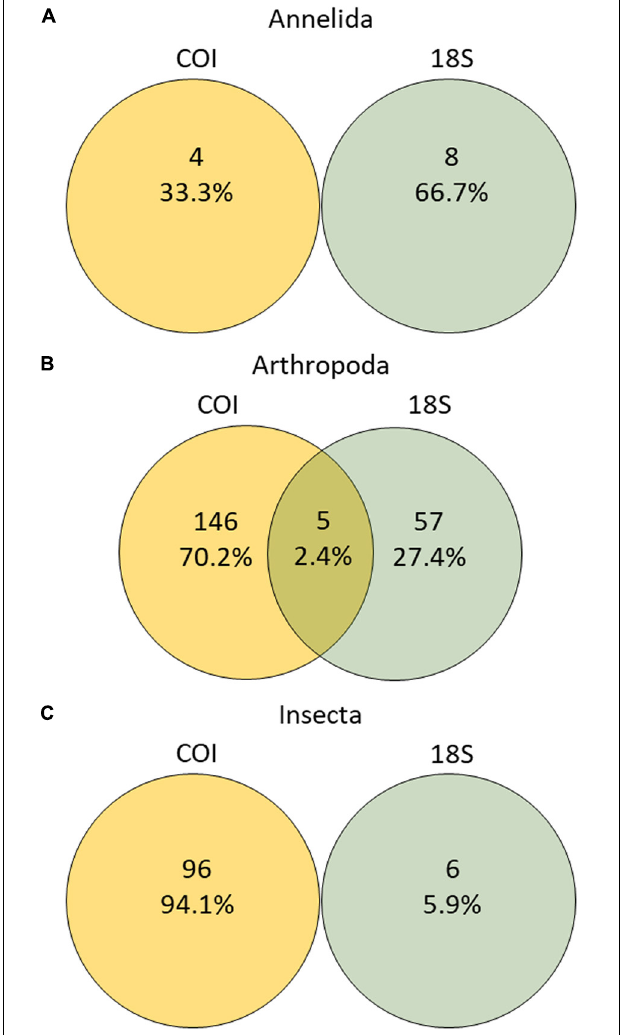
FIGURE 2 | Number of OTUs with unique species assignment (blastID ≥ 99%) recovered with either or both markers for the main soil metazoan